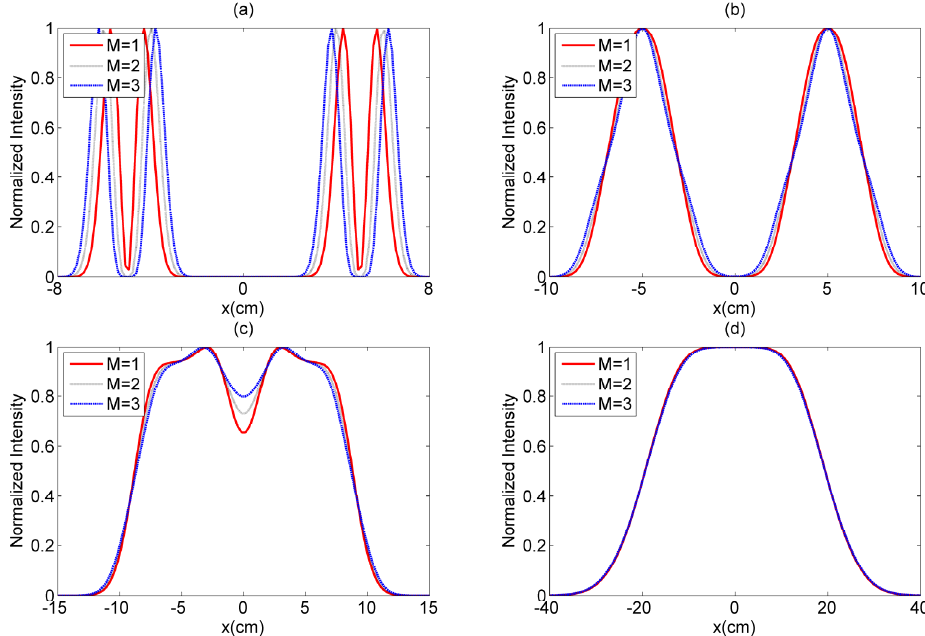
Figure 6. Cross sections ( y = 0) of the normalized intensity of a RPLMGSMV beam array with Q = 4